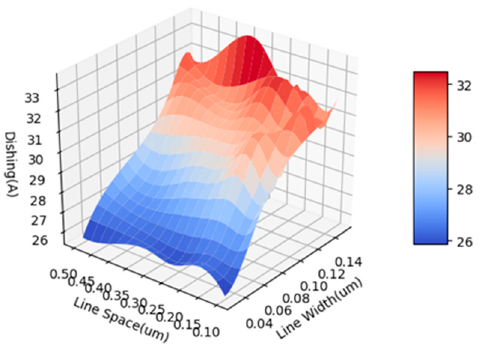
Figure 8. The dishing defects of the predictions of CNN-based CMP model. The RMSE is 2.02